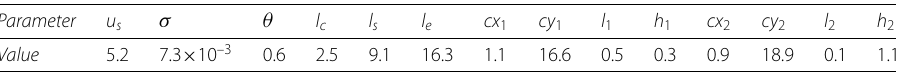
Table 3 Value of the optimal parameters in φ opt , solution of Problem (5) Parameter u s σ θ